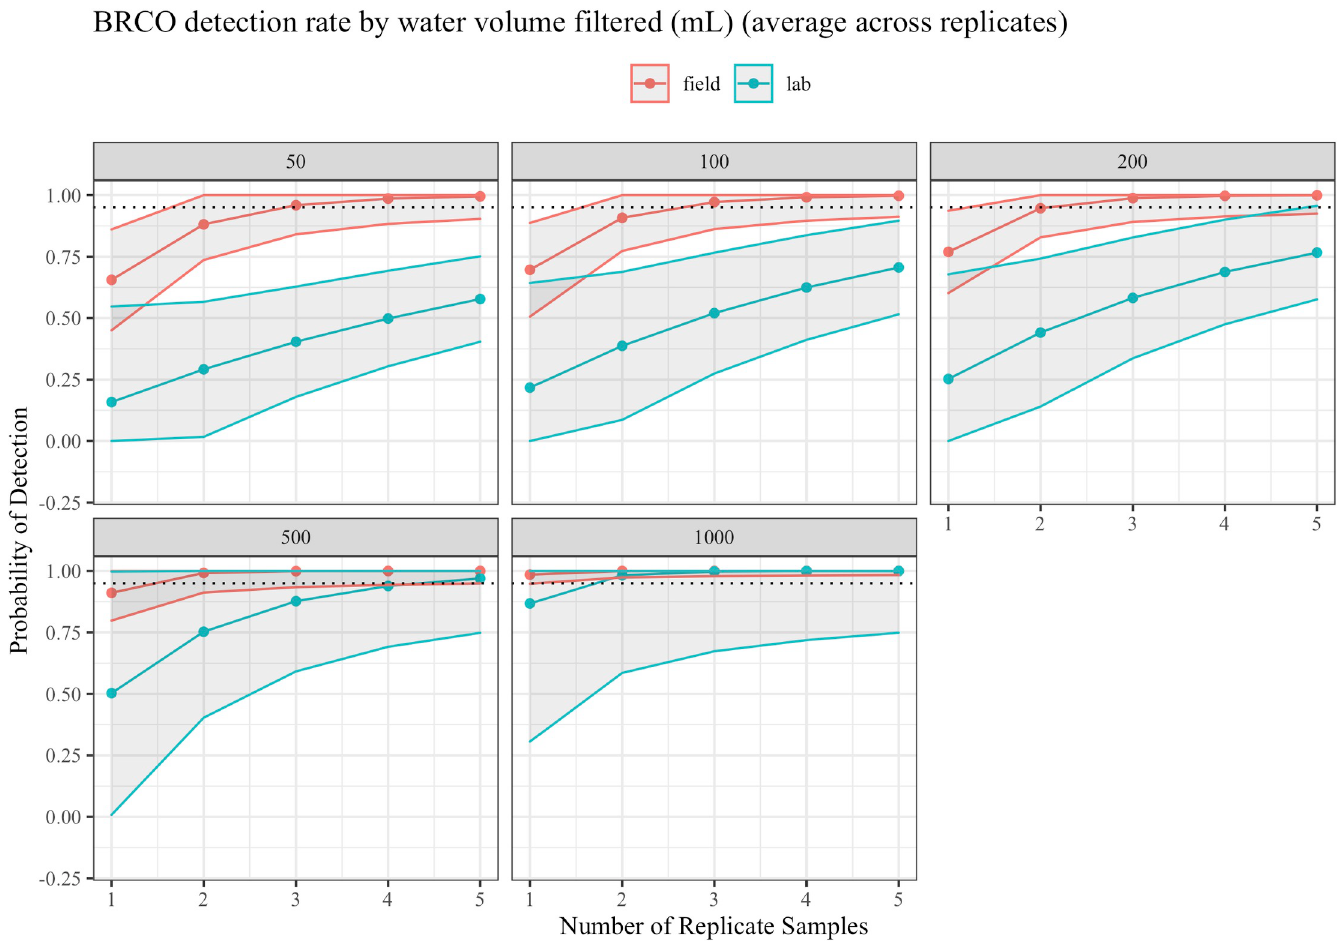
Fig 4. Probability of detecting BRCO using eDNA sampling across water volumes and replicate water samples. Volumes are measured in mL. Dotted line represents 95% detection probability.